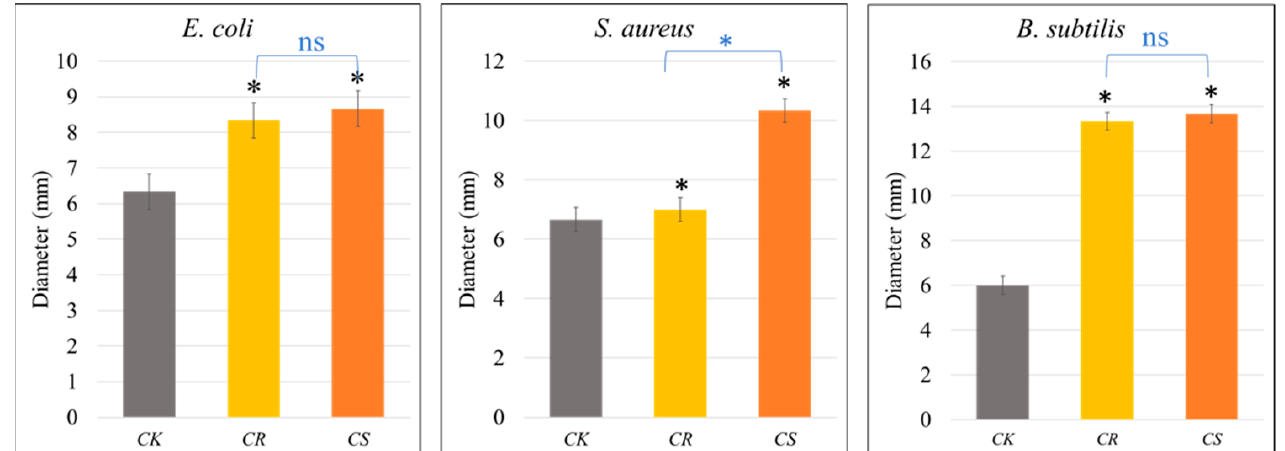
Figure 6. Antibacterial activities of the C. x sinensis and C. reticulata peels’ essential oil samples against Escherichia coli , Staphylococcus aureus , and Bacillus subtilis . The graphs represent the mean (n = 3) inhibition zone (mm) ± SD ( p < 0.05). Where, * and ns indicate that the differences between the means are significant and non-significant, respectively. The black * and ns show differences of the CR and CS with CK (blank group). The blue * and ns show differences between CR and CS.